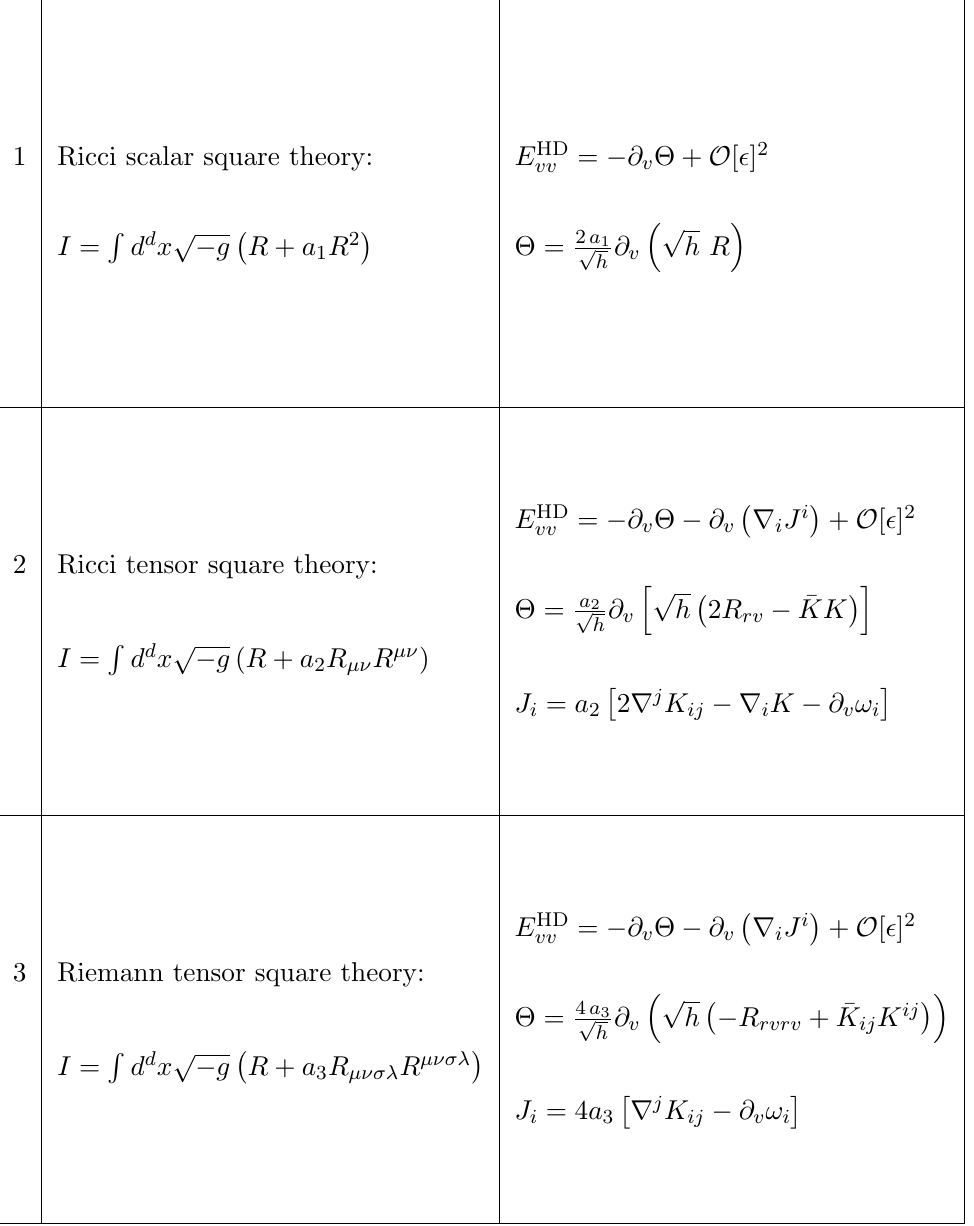
Table 1 . Table showing the higher derivative corrections to Einstein’s equations, for all possible 4-derivative theories of